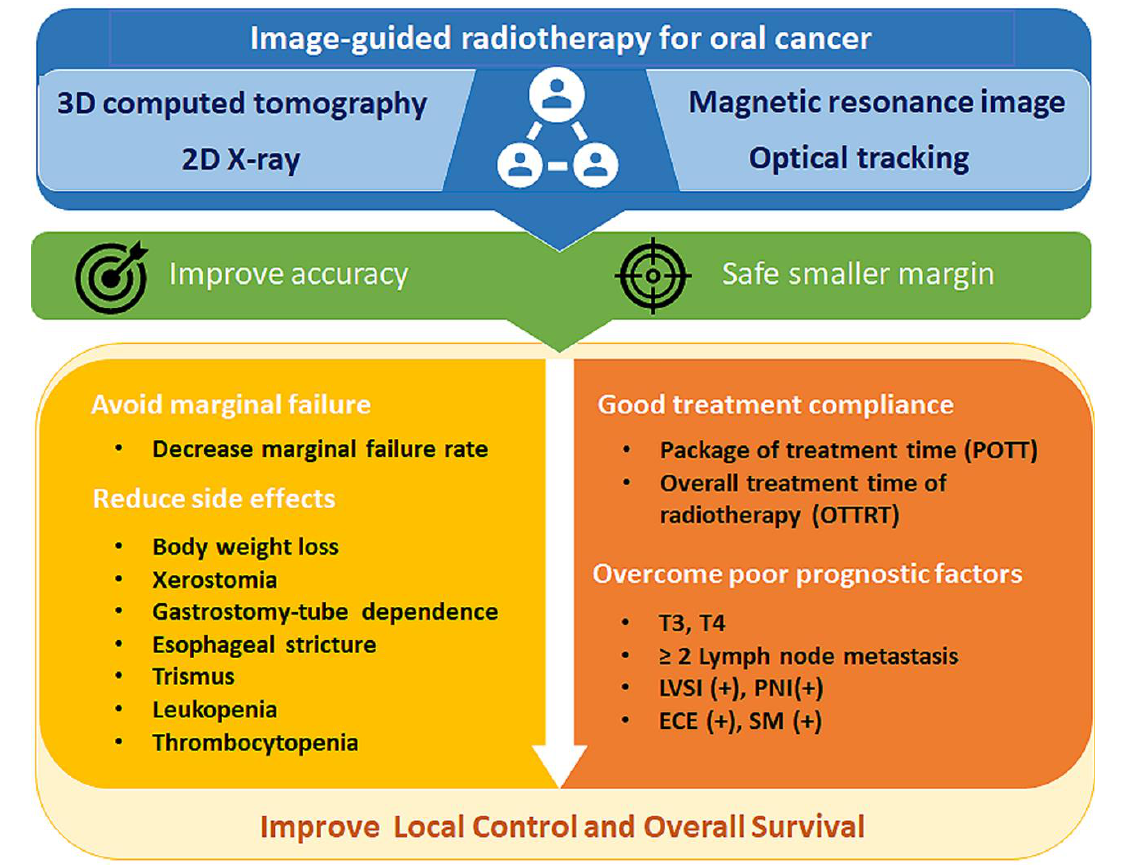
Figure 3. IGRT decreases toxicities, increases compliance, and overcomes the marginal failures that contribute to a better overall outcome and provide OCC patients with better quality of life.